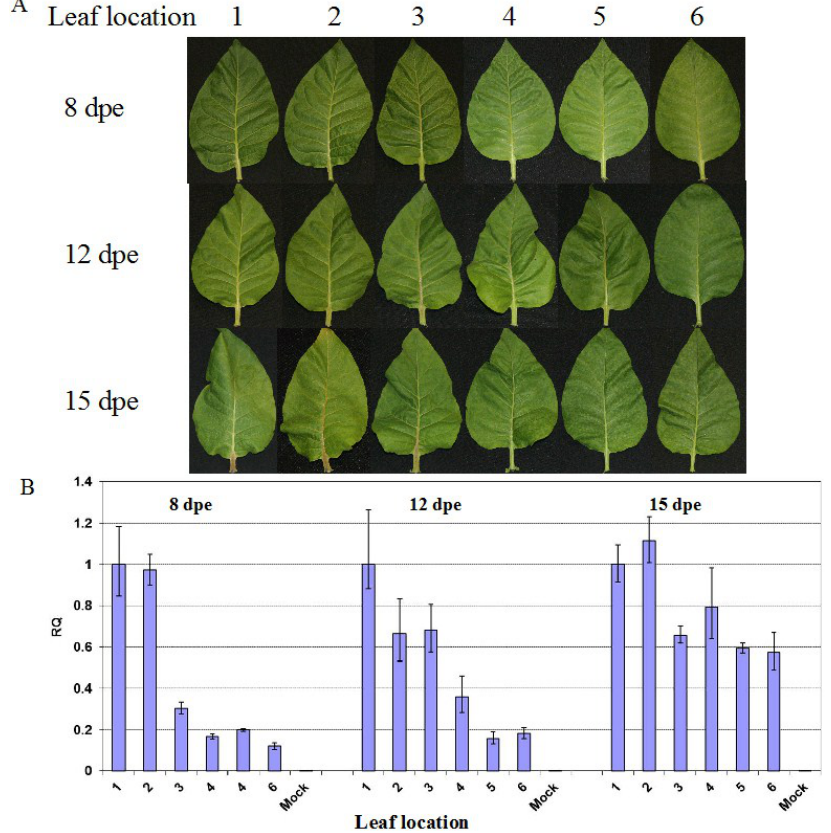
Figure 2. Effects of leaf age on the recovery phenotype in latterly emerging leaves of tobacco plants infected with PVY N:O -Mb58. ( A ) Symptoms in +1 to +6 leaves at the leaf age of 8, 12 and 15 days post-emergence (dpe); ( B ) Real-time RT-PCR analysis of the relative PVY level (RQ) after normalization with the COX1 level in the